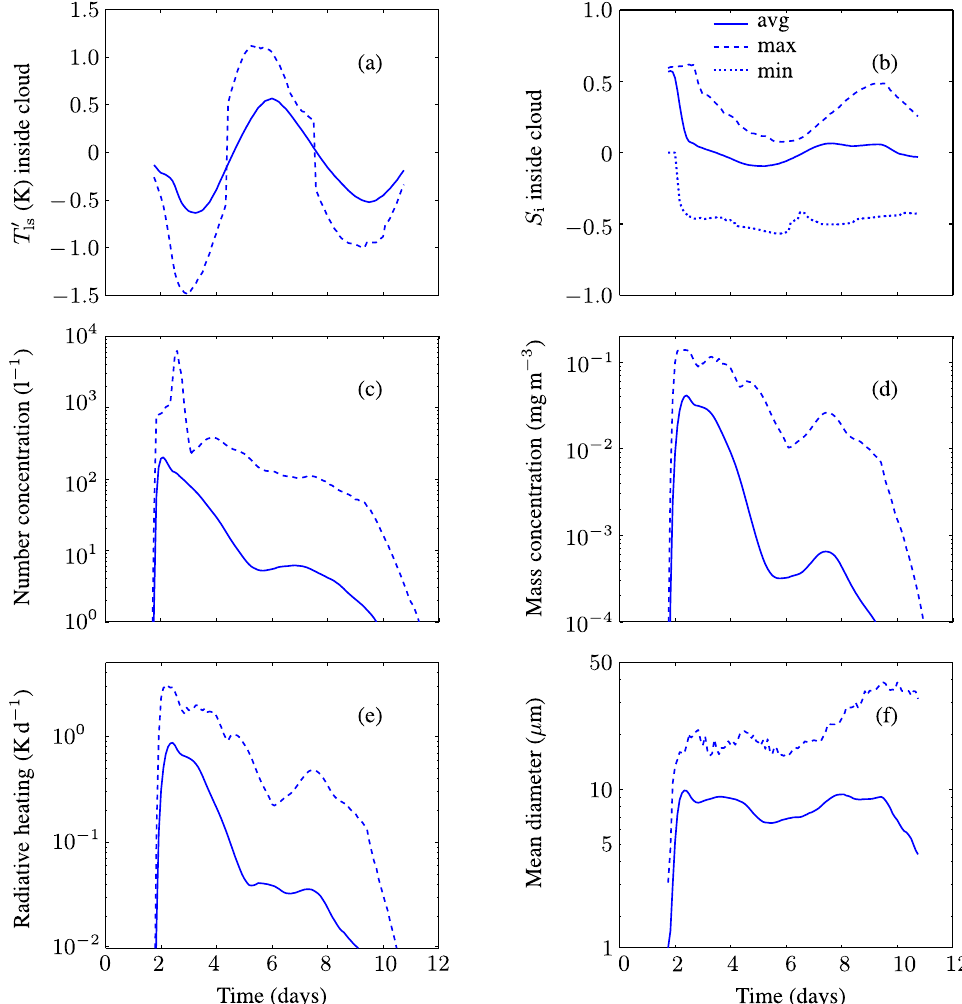
Fig. 5. Time evolution of the maximum (dash) and average (solid) over the cloudy region of the large-scale temperature perturbations (a) , supersaturation ratio (b) , ice number concentration (c) , IWC (d) , radiative heating rate (e) , and mean diameter of ice crystals (f) . Panels (c) – (f) are shown in logarithmic scale. In (b) the minimum (dot) over the cloudy region of the supersaturation ratio is also shown.